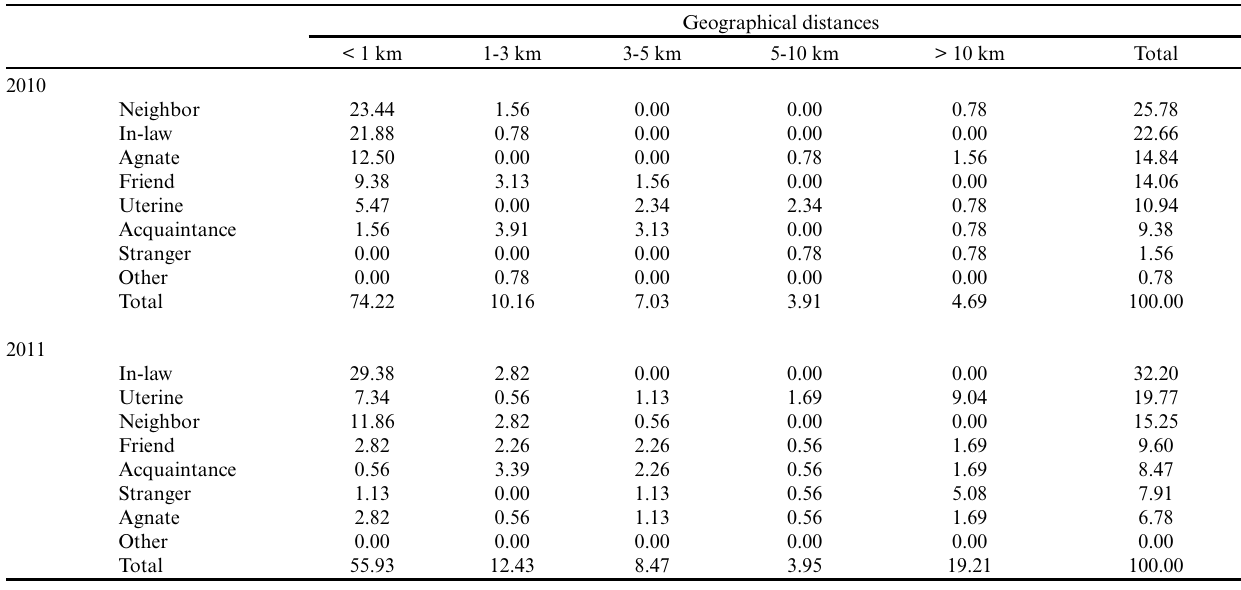
Table 3 . Proportion of seed acquisition events according to the type of relationship and distance between providers and recipients in 2010 and 2011.